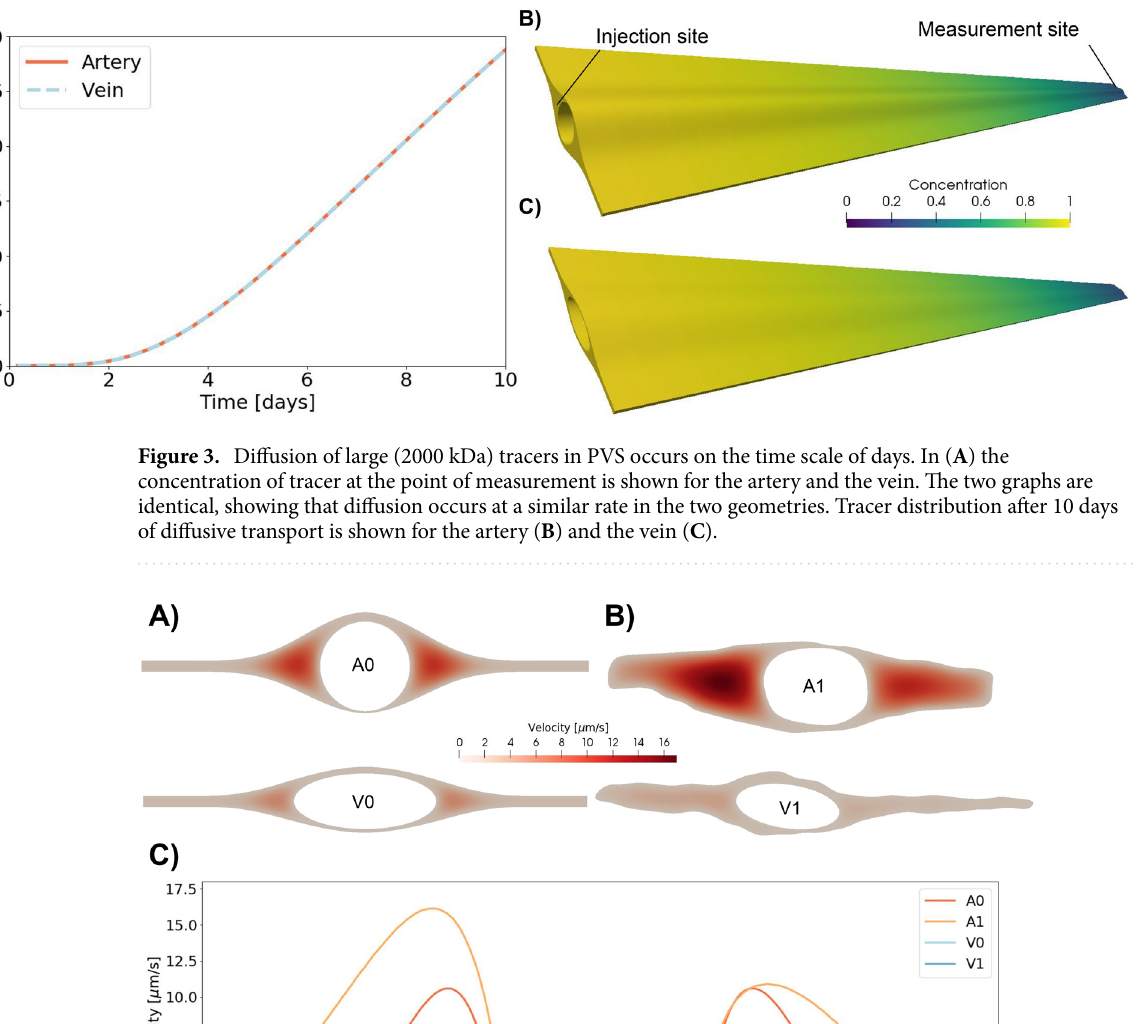
and the vein (C) after 10 days of diffusive transport. The tracer was evenly distributed at all cross-sections. Thus, for pure diffusion, the shape of the PVS did not influence the tracer transport. Periarterial geometries induce higher fluid velocities. Fluid velocities and bulk flow in the PVS were induced by a static pressure gradient of 1.46 mmHg/m along the length of the PVS 16 . Although vascular pulsa- tions play an important role in generating pulsatile flow in the PVS, the transport of solutes, as considered here, is dominated by bulk flow rather than pulsatile motion 21 . Velocities were higher in the larger open spaces sur- rounding the arteries (both idealized and image-based) than in other regions (see Fig. 4). The peak (and average) fluid velocity in the idealized periarterial and perivenous spaces was 11 (3) and 5 (1) µ m/s, respectively, and 17 (6) and 3 (1) µ m/s in the image-based periarterial and perivenous spaces. The velocity was higher on each side of the blood vessels, with little or no flow over the top or below the vessel. We note that even though the PVS